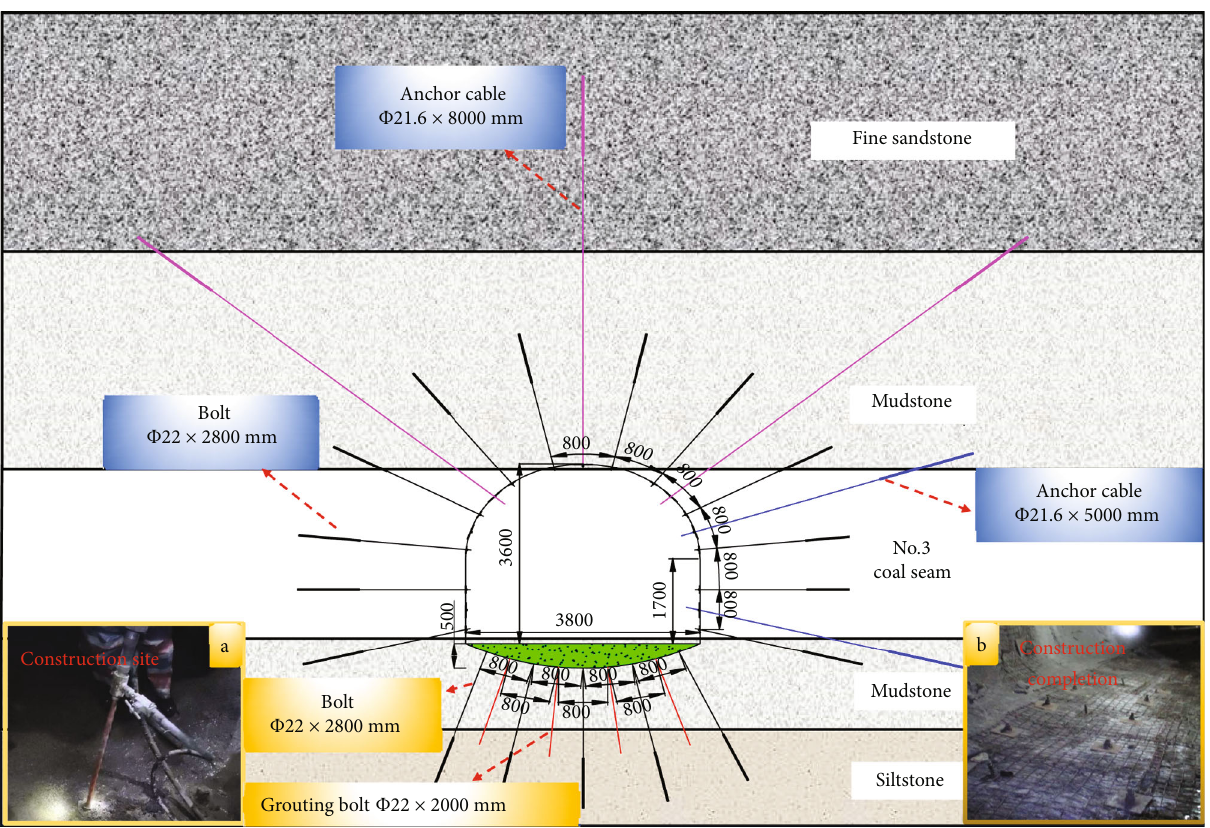
Figure 13: Section support scheme.